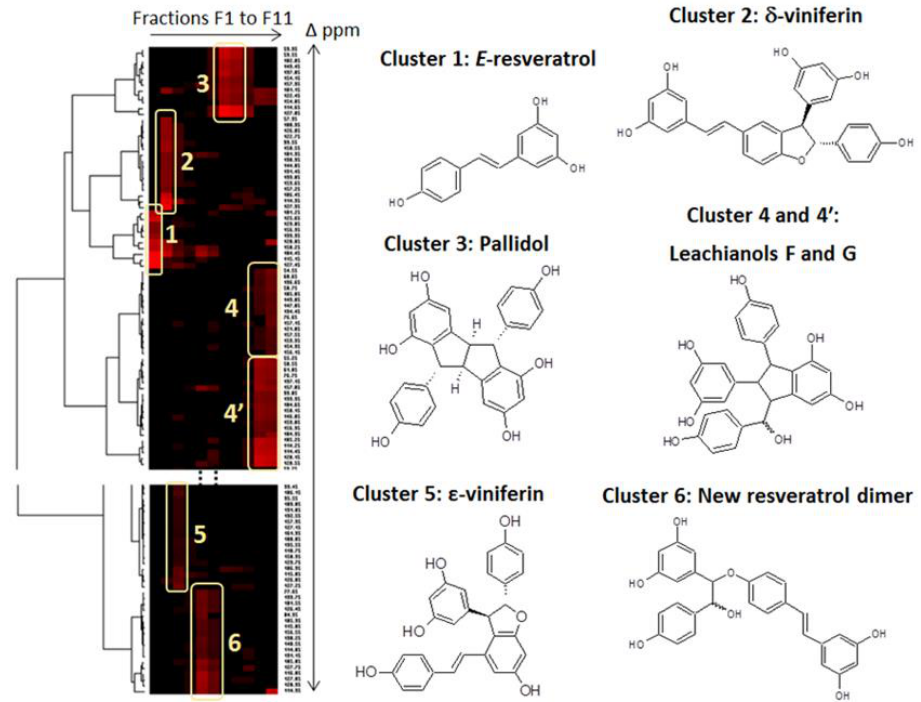
Figure 2. 13 C-NMR chemical shift clusters obtained by applying Hierarchical Clustering Analysis